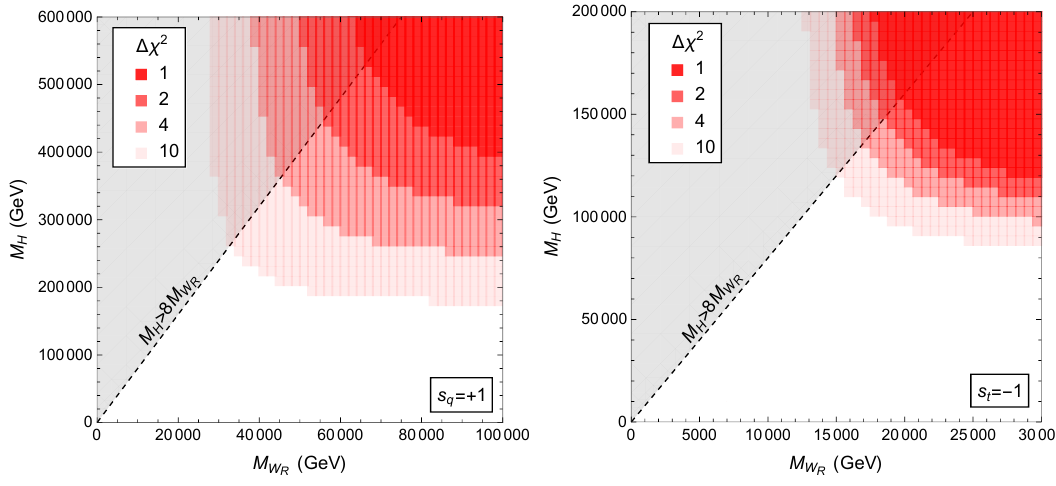
- M plane, after H R = +1 and t